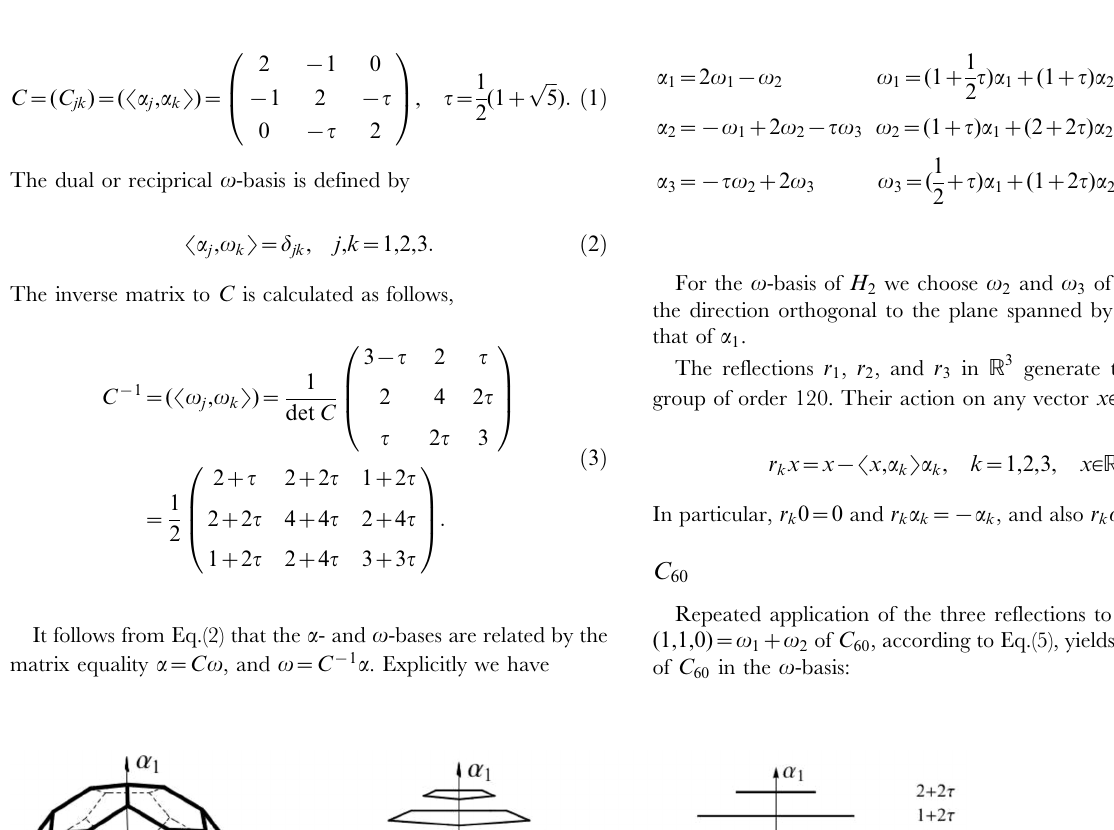
Figure 1. The structure of the C 60 molecule. (a) The polytope C 60 is formed by 60 vertices equidistant from its center. Its surface consists of 12 regular pentagons and 20 regular hexagons. All 90 edges are of the same length. (b) The C 60 polytope viewed in the direction almost parallel to the plane spanned by v 2 and v 3 , which makes the H 2 orbits (pentagons and decagons) easy to identify. (c) The C 60 polytope viewed in the direction parallel to the H 2 plane spanned by v 2 and v 3 . Surface edges of C 60 are omitted in (b) and (c). Horizontal segments are projections of the H 2 orbits. The number in a row shows the a 1 coordinate of the H 2 orbit. The vertical direction is that of a 1 .